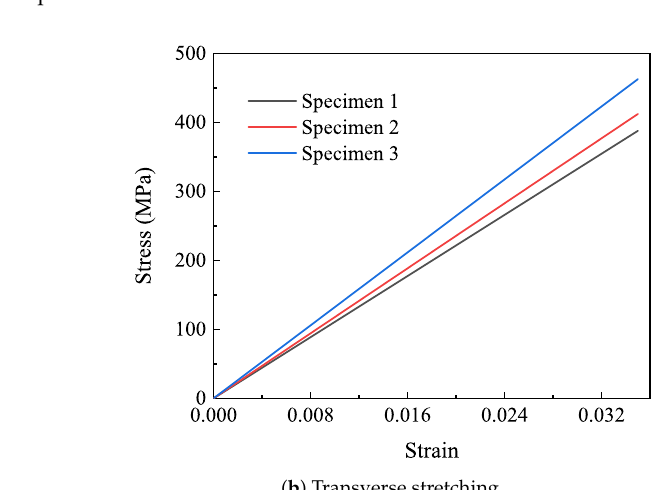
Figure 15. Transverse fracture specimen.